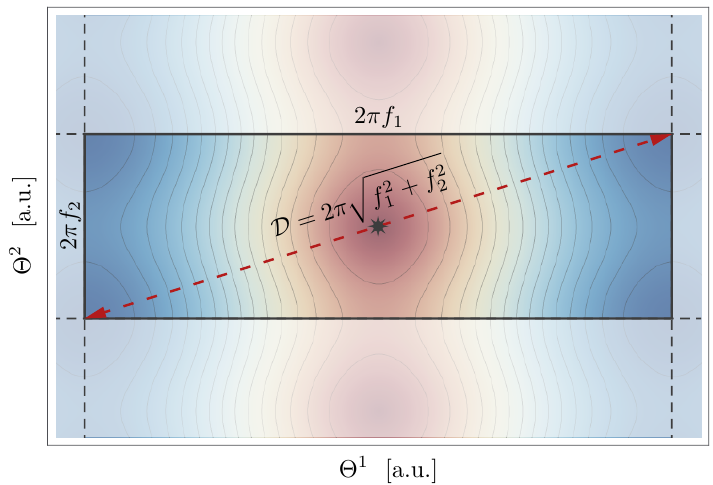
Figure 12 . Illustration of the tile for N-(cid:13)ation. The diameter is the Pythagorean sum of the f I . T The tile consists of an N -dimensional hyperrectangle with side-lengths 2 (cid:25)f I ,